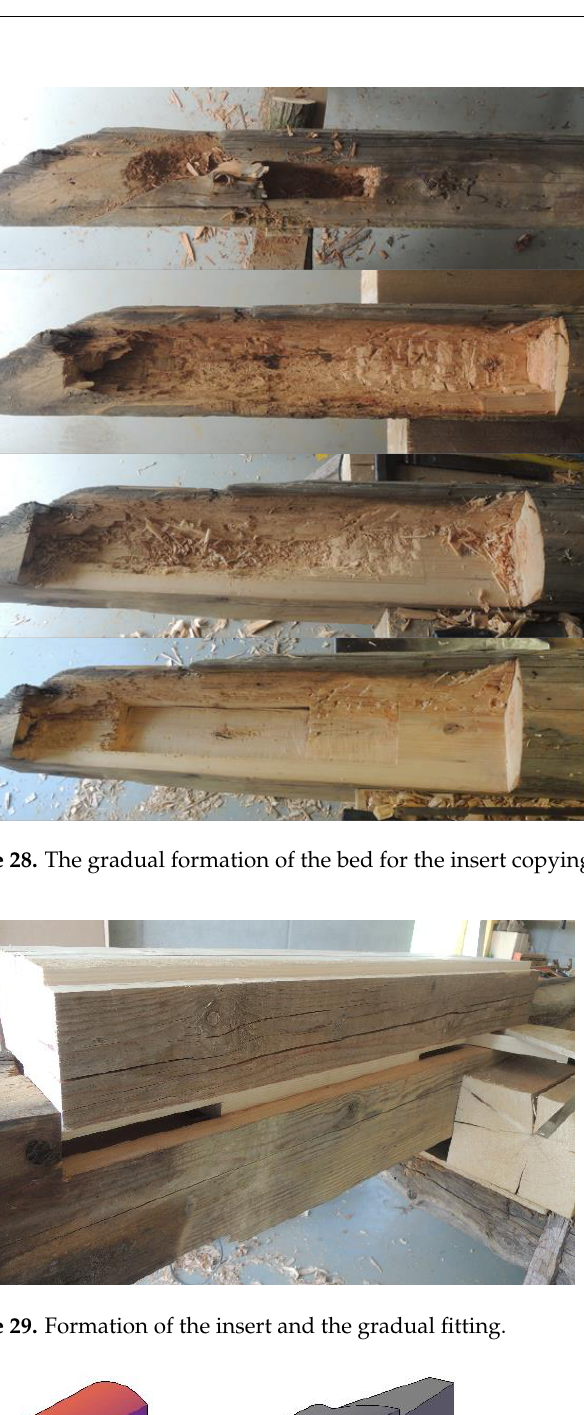
Figure 27. Finally cleaned part of the damaged beam.